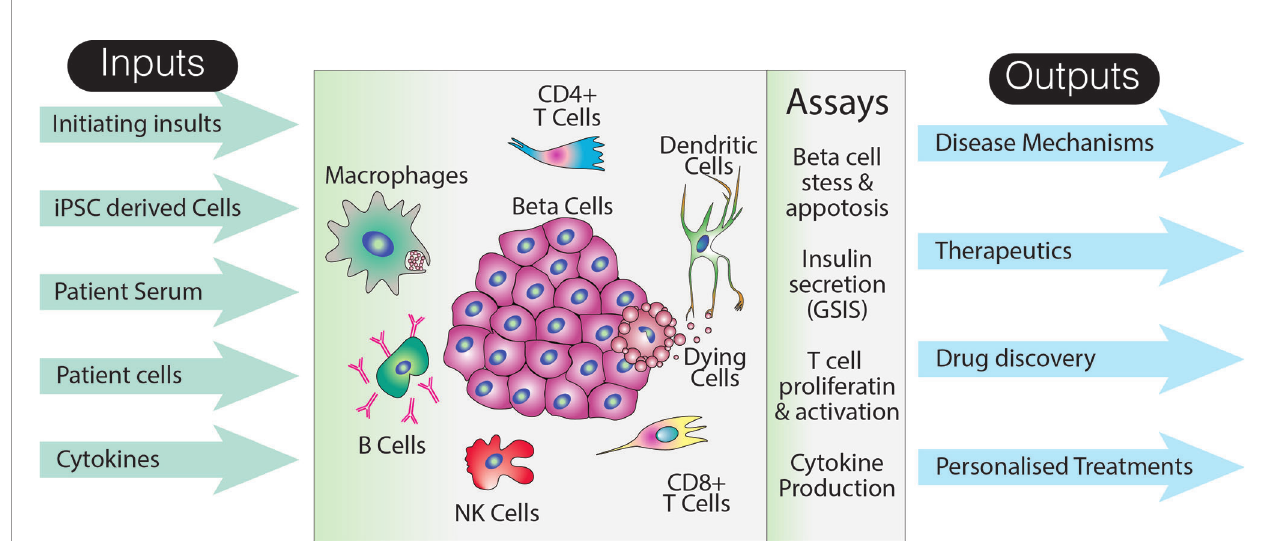
FIGURE 2 | Utility of an idealized model of T1D. The schematic suggests various inputs to the model, how the effects of these inputs could be assayed, as well as long term potential outputs. Note that this representation of the model does not speci fi cally include a host of non-immune and non-endocrine cells which may also impact on the disease pathogenesis. Additionally, although a limited number of assays are shown, analyses speci fi c to particular cell types are likely to increase the breadth and depth of data that could collected from such a